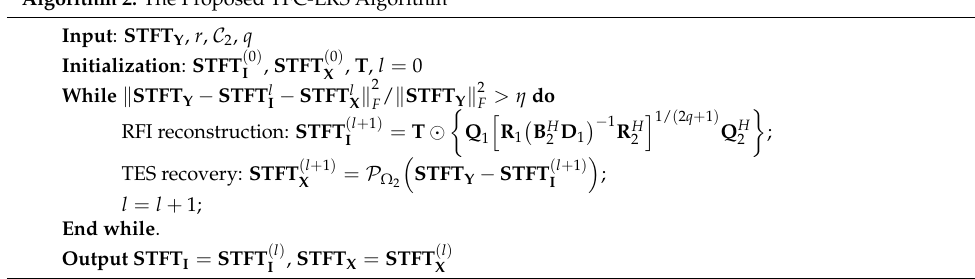
Algorithm 2. The Proposed TFC-LRS